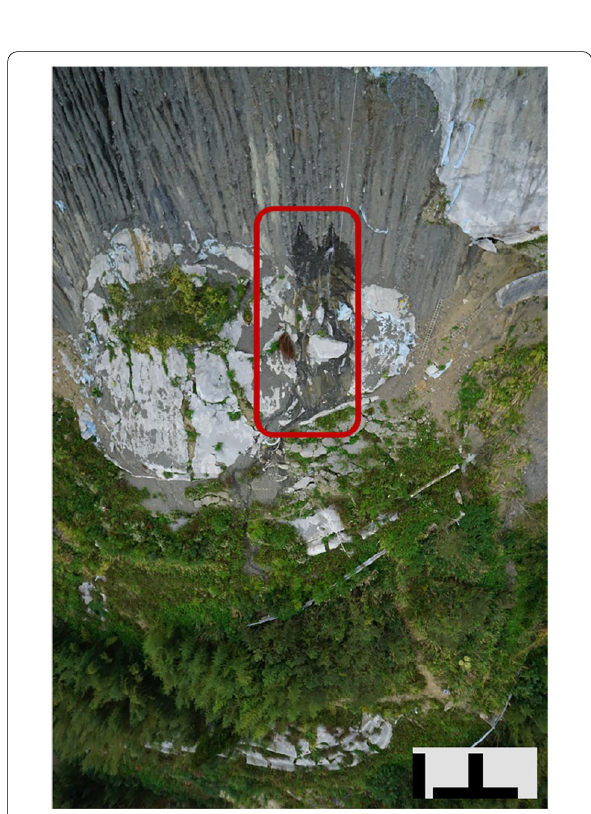
Fig. 6 The groundwater flow exfiltration in the study